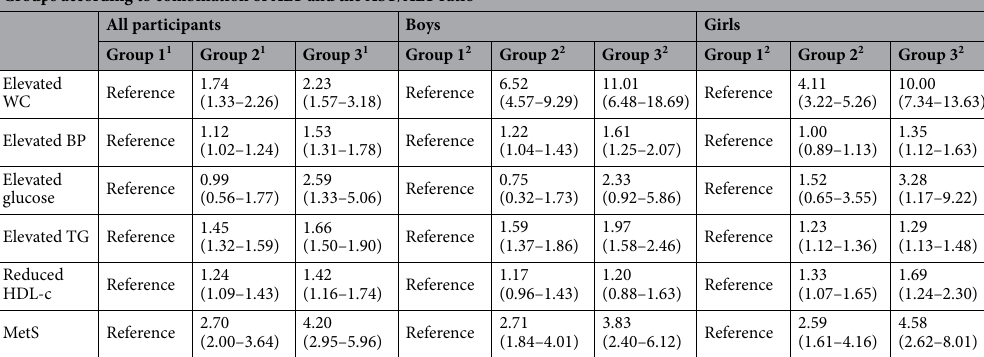
Table 5. The adjusted prevalence ratio and 95% confidence intervals of MetS and its components according to groups according to the combination of alanine aminotransferase (ALT) and the AST/ALT ratio in subjects aged 10–18 years ( n = 8091). WC, waist circumference; BP, blood pressure; TG, triglyceride; HDL-c, high- density-lipoprotein cholesterol; ALT, alanine aminotransferase. Group 1 was classified as the normal group based on alanine aminotransferase (ALT) level and the normal group based on the AST/ALT ratio. Group 2 was classified as i) the borderline-high group based on ALT level and the normal group based on the AST/ ALT ratio ii) i) the borderline-high group based on ALT level and the borderline-high group based on the AST/ALT ratio, and iii) normal group based on ALT levels and borderline high group based on the AST/ALT ratio. Group 3 was classified as i) the high group based on ALT level and normal, the borderline-high, or the high group based on the AST/ALT ratio ii) the high group based on the AST/ALT ratio and the normal, the borderline-high, or the high group based on ALT level. Model 1: The prevalence ratio and 95% confidence interval of metabolic syndrome (MetS) and its components according to groups for the combination of ALT and the AST/ALT ratio were determined using multiple logistic regression after adjustment for sex, age, body mass index (BMI) standard deviation score (SDS), alcohol consumption, smoking, physical activity, rural residence, household income, and diagnosis of hypertension, type 2 diabetes mellitus (T2DM), and dyslipidemia in all participants. Model 2: The prevalence ratio and 95% confidence interval of MetS and its components according to groups for the combination of the AST/ALT ratio were determined using multiple logistic regression after adjustment for age, BMI SDS, alcohol consumption, smoking, physical activity, rural residence, household income, and diagnosis of hypertension, T2DM, and dyslipidemia in the respective